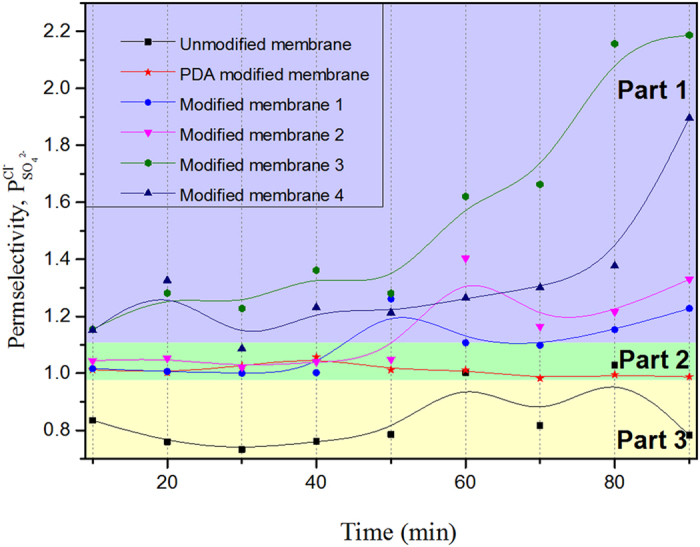
The permselectivity of Cl−/SO42− of the modified and unmodified AEM.